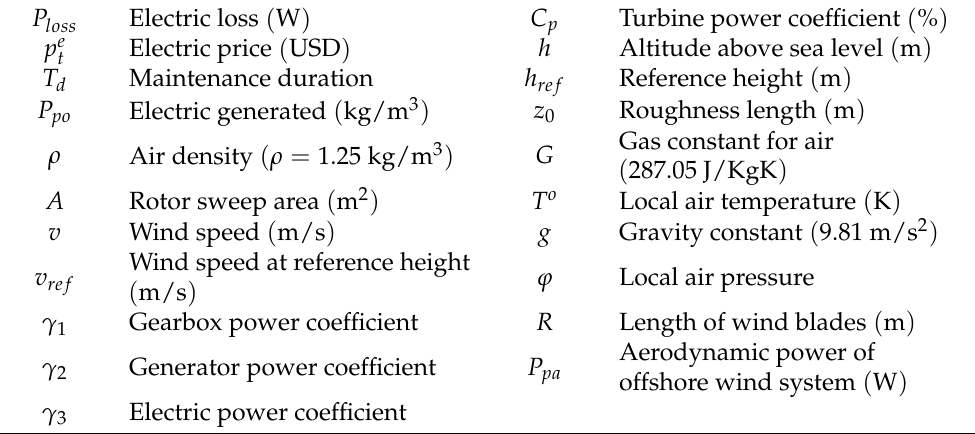
Table 1. Nomenclatures used in the generated electricity